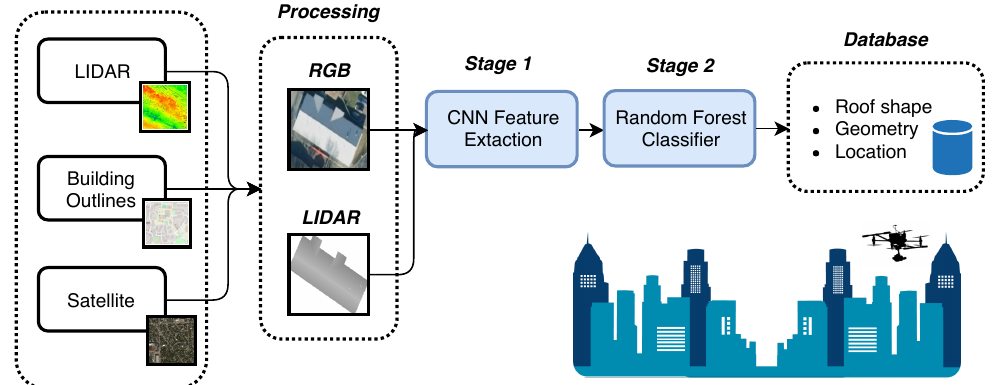
Figure 1. Roof classification data fusion and processing pipeline. LiDAR, building outlines, and satellite images are processed to construct RGB and LiDAR images of a building rooftop. In Stage 1, these images are fed into a CNN for feature extraction, while Stage 2 uses these features with a random forest for roof classification. These data can be stored for quick reference, e.g., navigation or emergency landing site